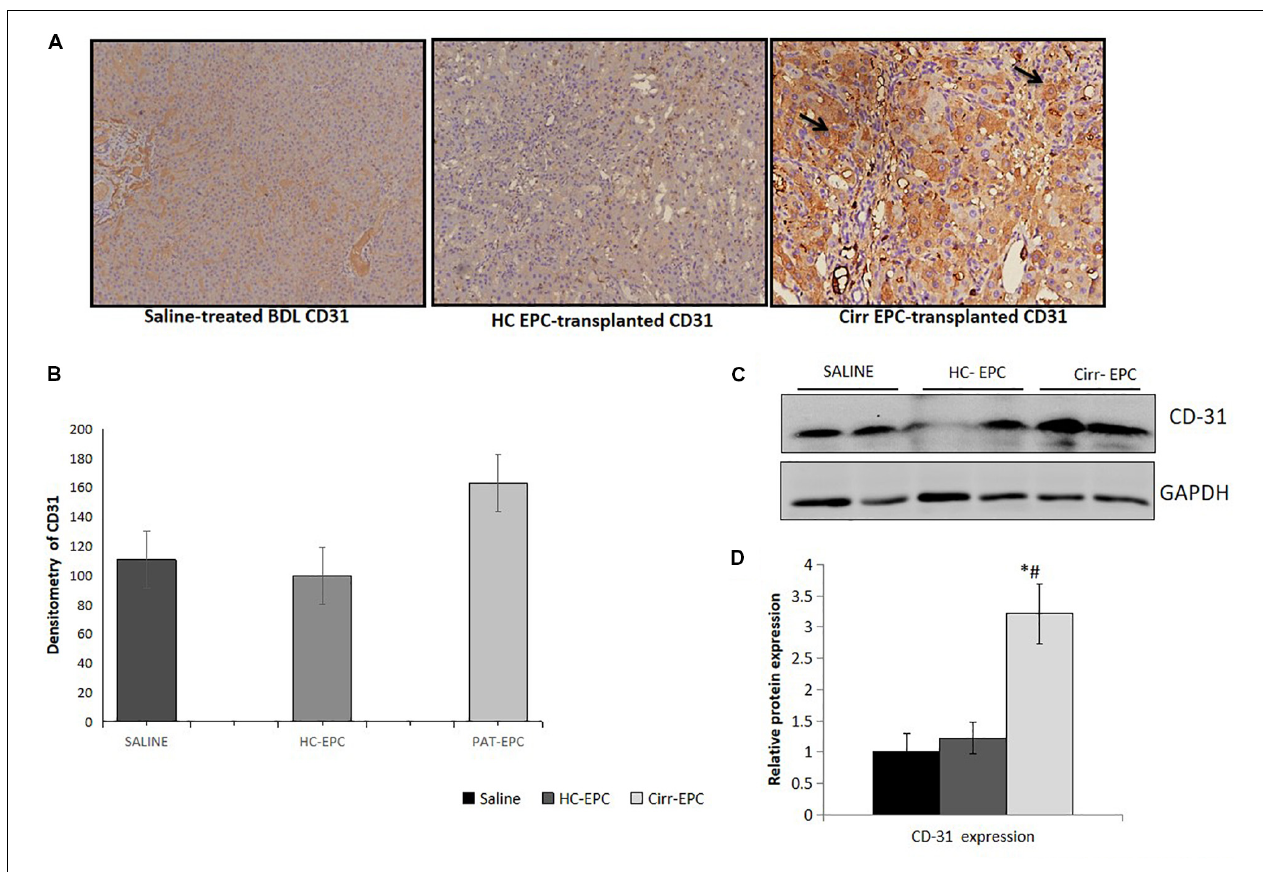
FIGURE 5 | Histochemical staining of liver tissues sections (10x) in saline-treated, healthy (HC), and cirrhotic (PAT) EPC-transplanted BDL rats for angiogenic markers. (A) CD31, (B) Densitometric analysis of CD31, (C) Representative western blots of CD31, and (D) Densitometric analysis of western blot in saline-treated, control, and cirrhotic EPC-transplanted BDL rats ( N = 8). * P < 0.05 vs. saline, #, vs.